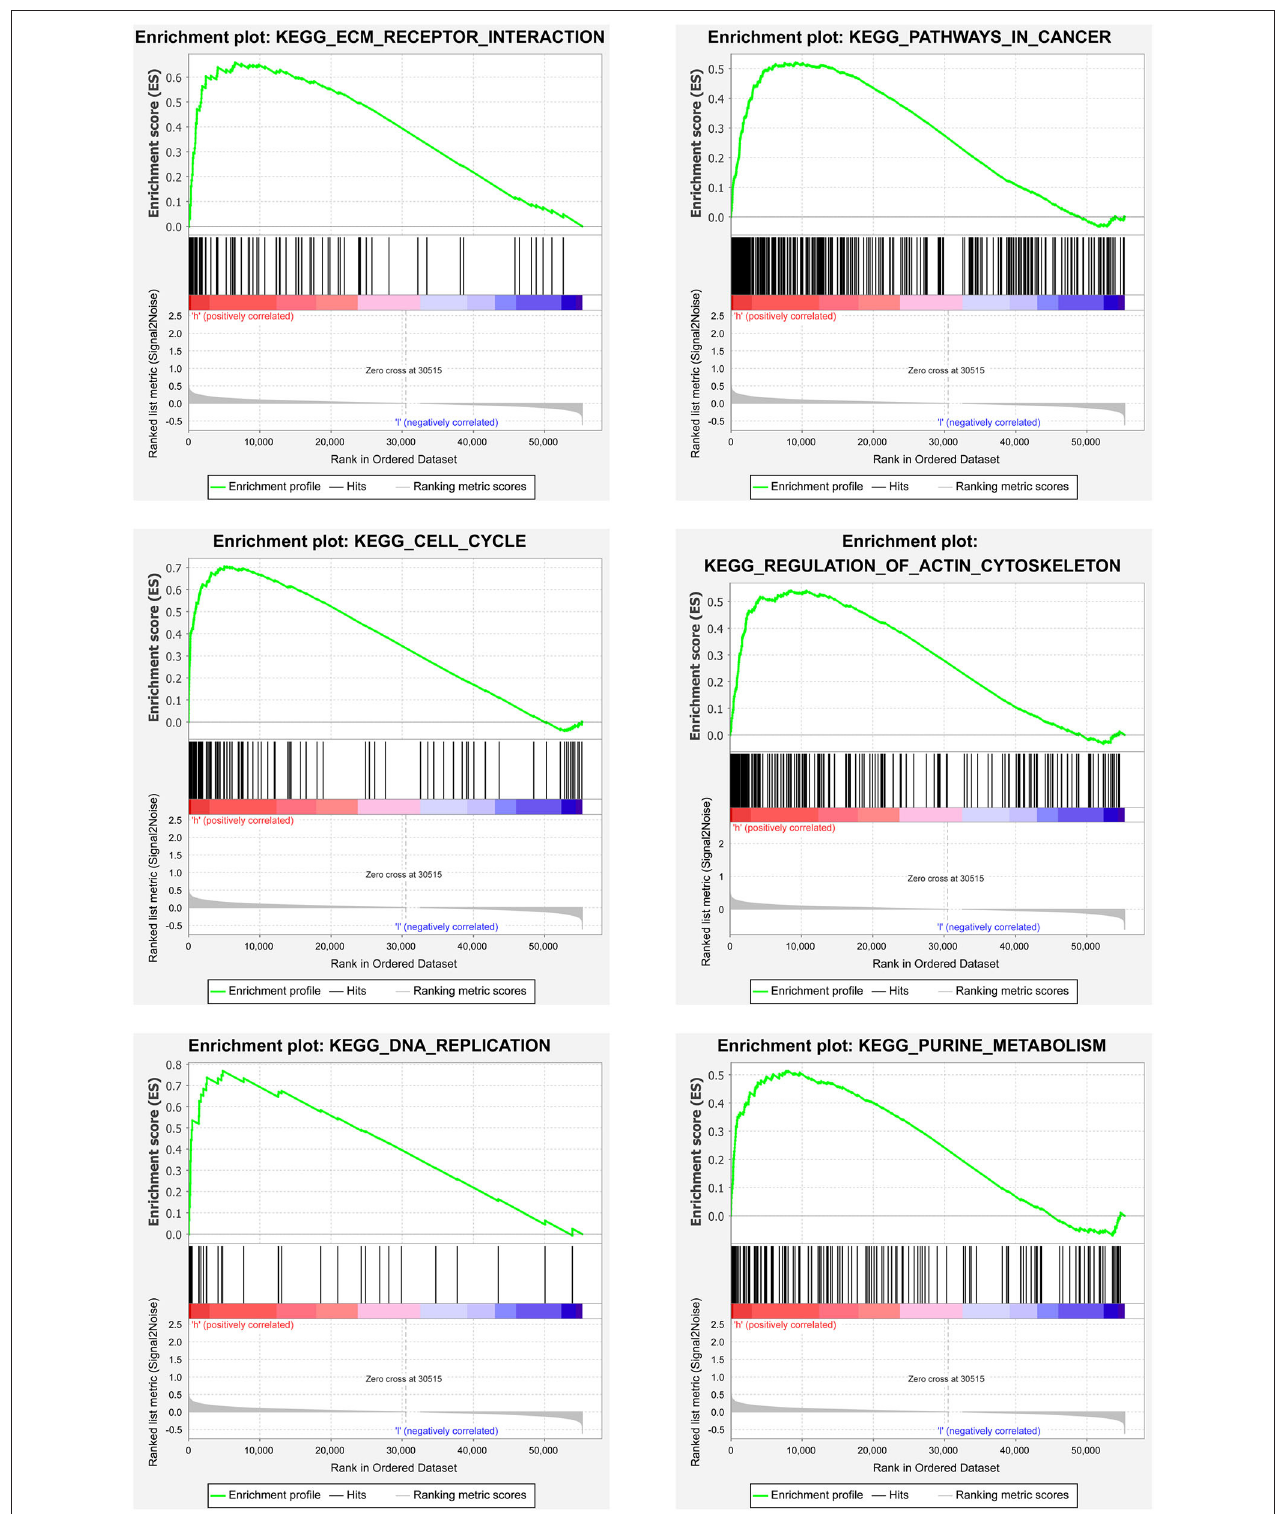
FIGURE 6 | Gene set enrichment analyses (GSEA) analyses between the two risk pRCC groups divided by the lncRNAs related to ferroptosis in TCGA.